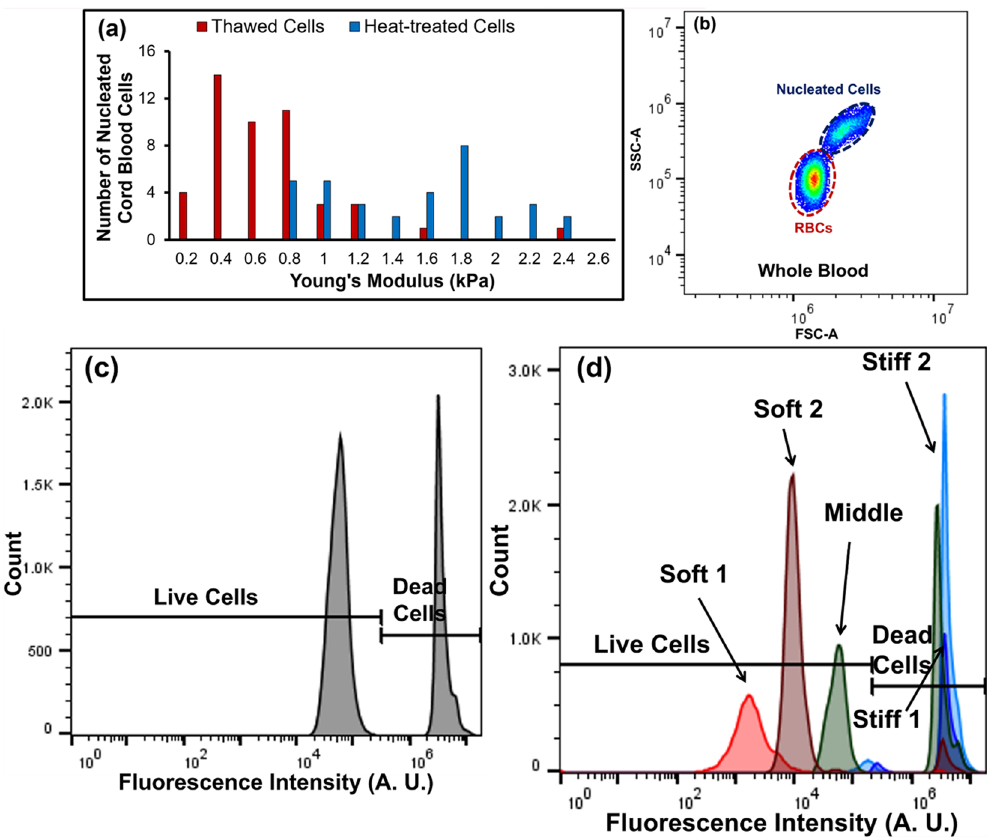
Figure 7. AFM data and flow cytometry results obtained from cord blood ( a ) distribution of Young’s modulus for nucleated cord blood cells ( N > 30 ); ( b ) scatter plot of cord blood to distinguish nucleated cells from red blood cells; ( c ) EthD-1 staining of live and dead nucleated cells in the cord blood; ( d ) viability of nucleated cells collected from different outlets after microfluidic